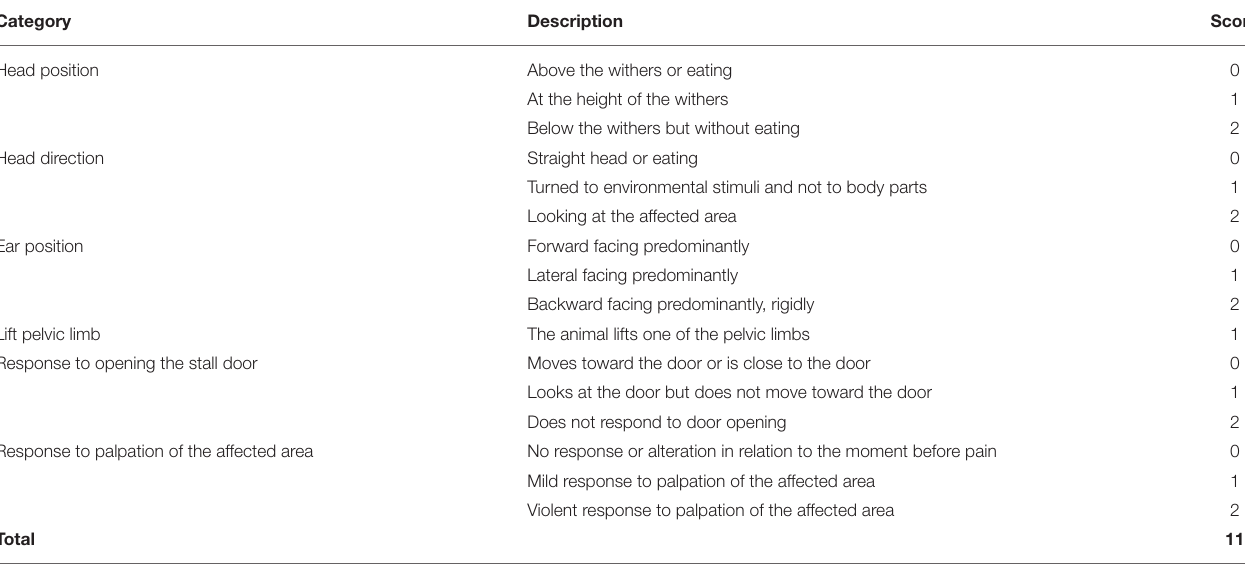
TABLE 6 | Definitive DOPS (Donkey pain